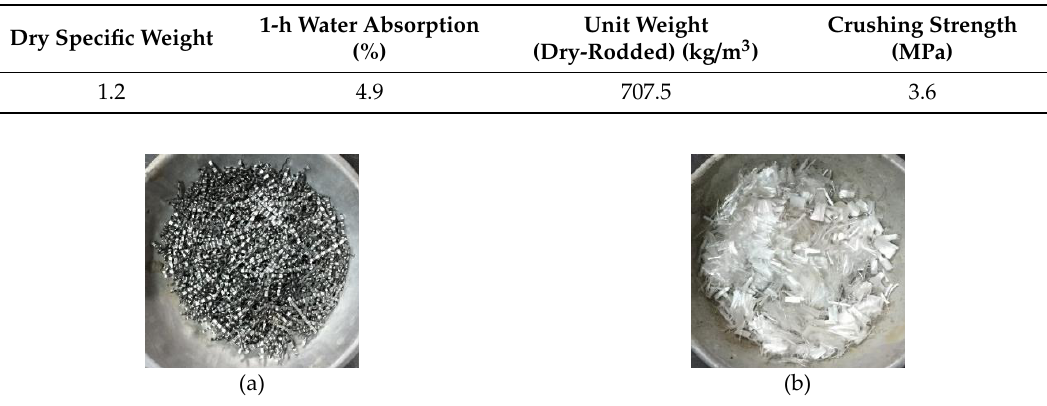
Figure 1. Appearance of fibers: ( a ) wavy steel fibers and ( b ) polypropylene fibers.